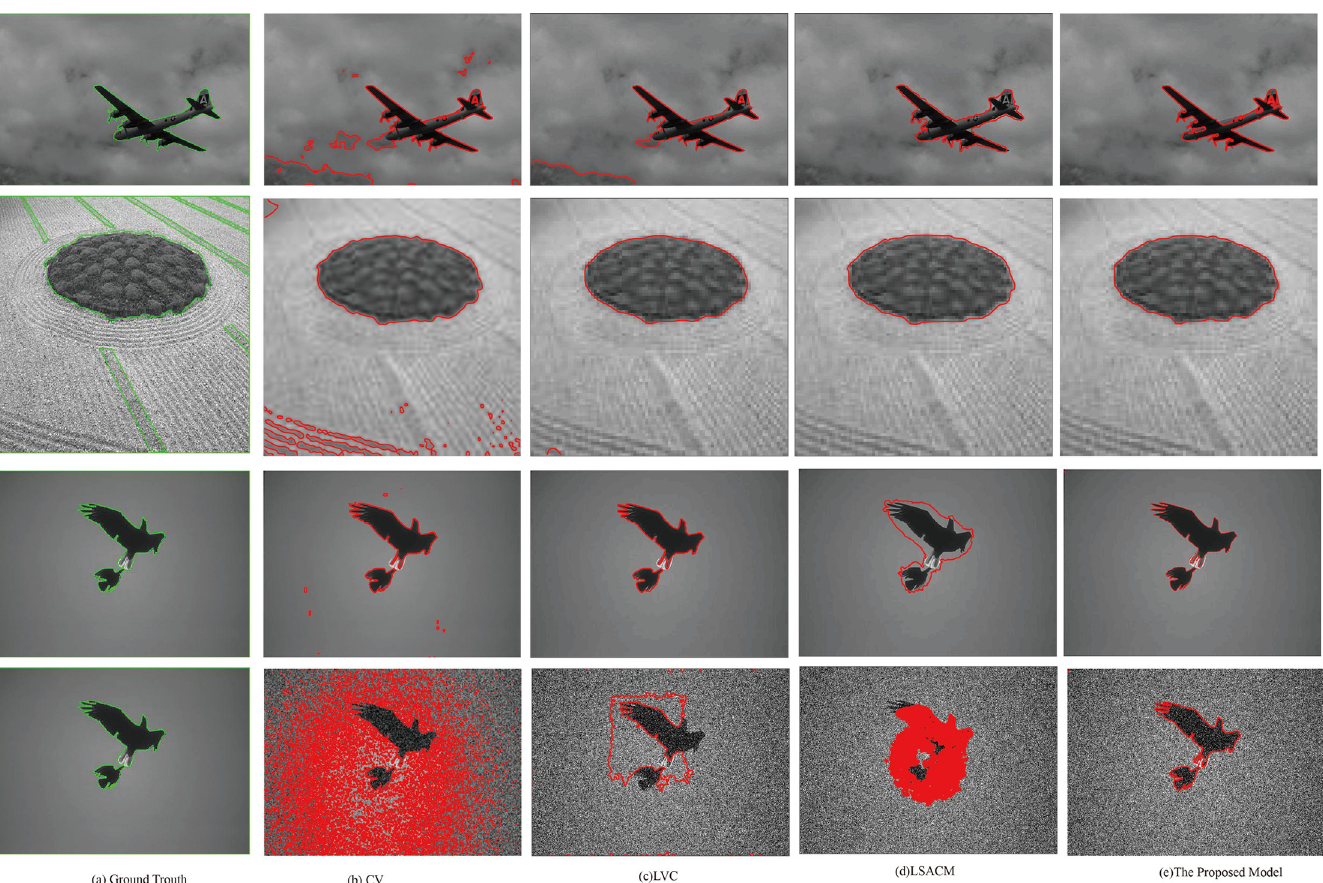
Fig 6. Comparisons of the proposed model with the CV model the LVC and the LSACM, they should be listed as: (a) The ground truth; (b) Segmentation results of the CV model; (c) Segmentation results of the LVC model; (d) Segmentation results of the LSACM;(e) Segmentation results of the proposed model.